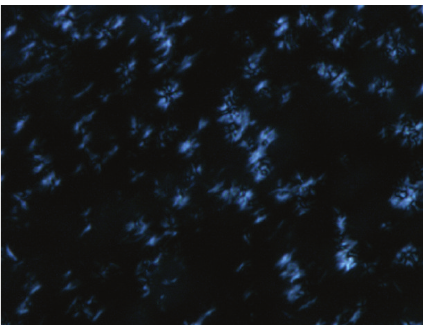
Figure 5: Optical image of PCL after 1800 seconds of isothermal crystallization (hot stage temperature = 45 ∘ C), 50x (image dimen- sions: 175 × 131.2 𝜇 m).